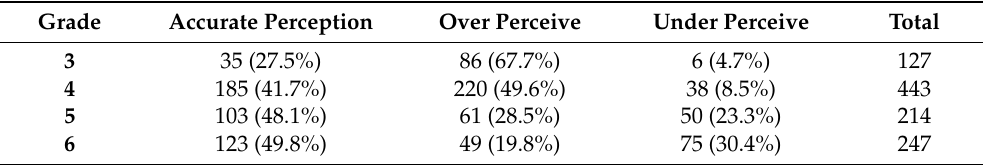
Table 5. Number (and percentage) of children assigned to each category of perception according to